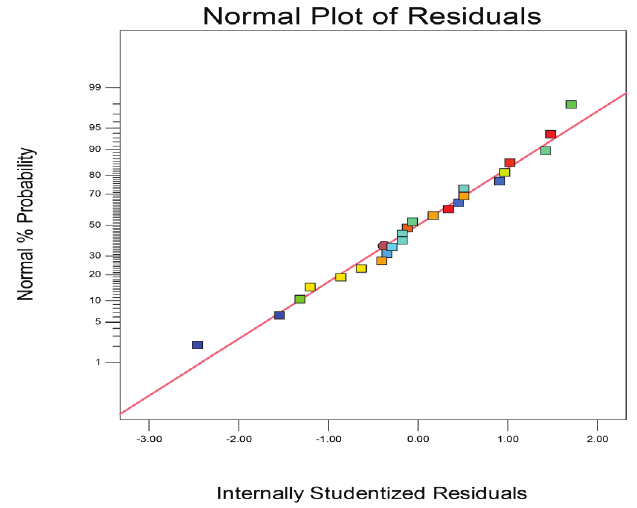
FIGURE 3 - Normal distribution